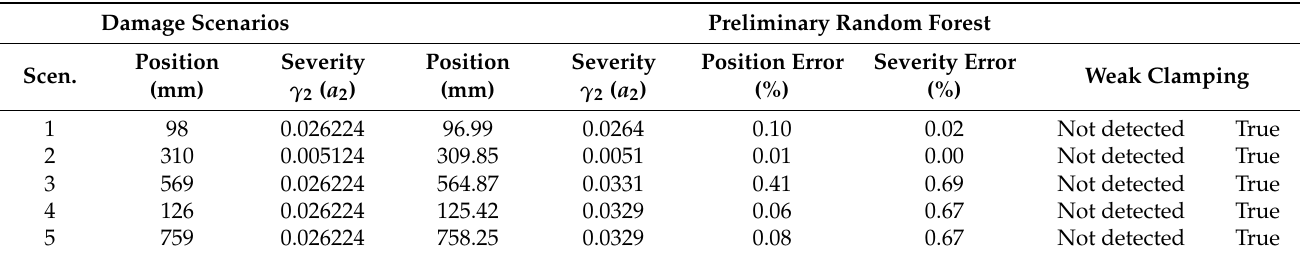
Table 12. Results obtained using the preliminary Random Forest model.